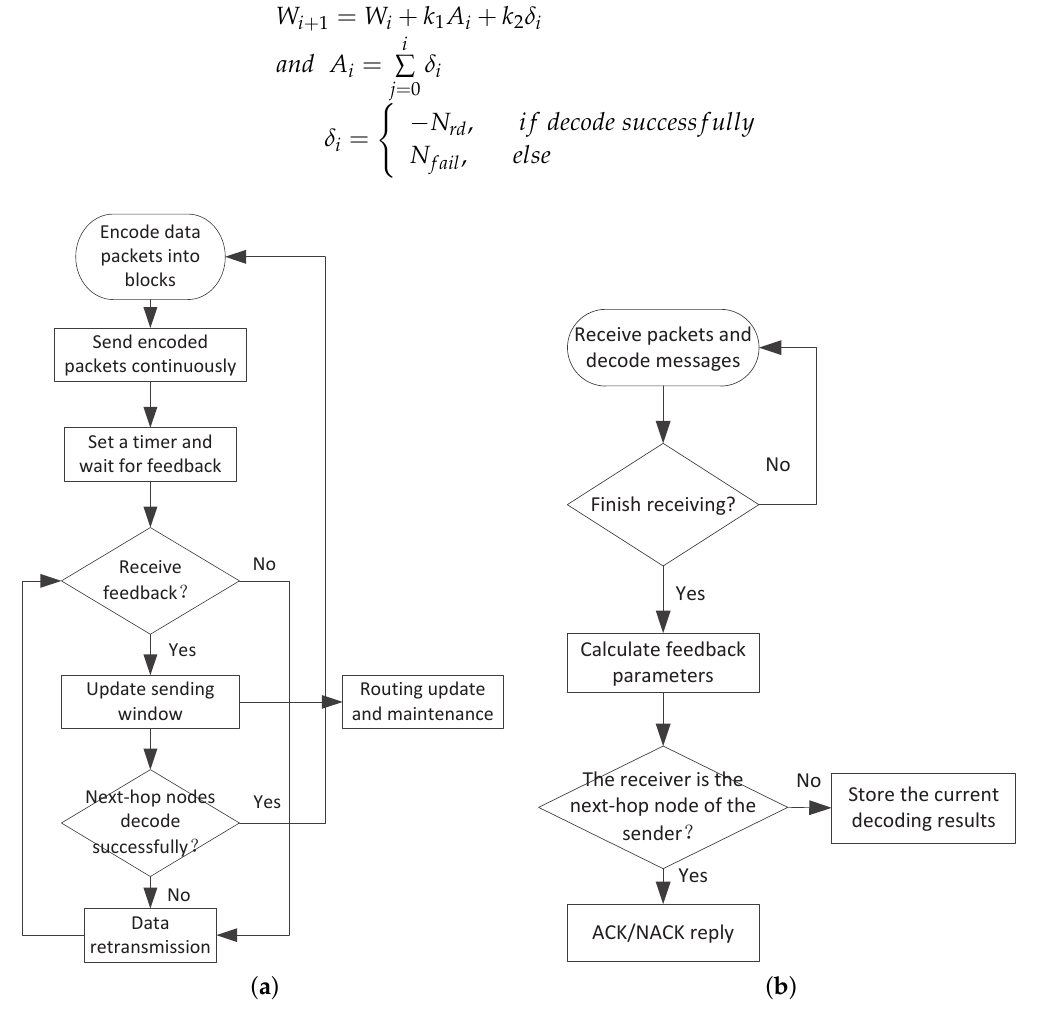
Figure 2. ( a ) The sending procedure for NCHARQ; ( b ) The receiving procedure for